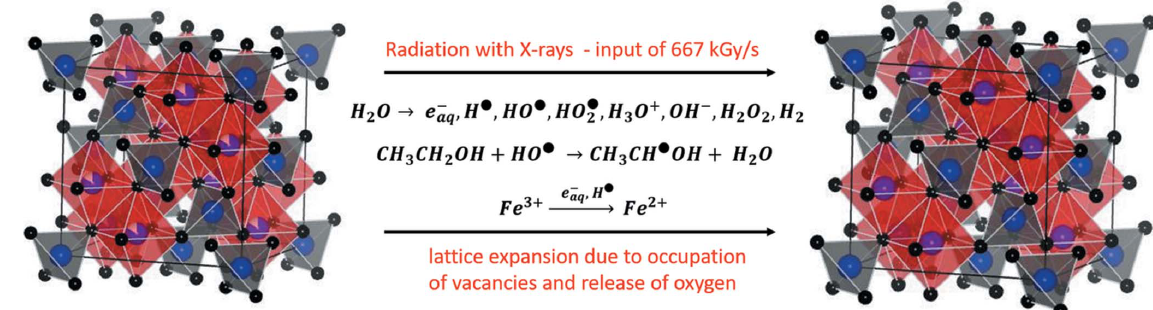
Figure 2 Change of the crystalline structure of the IONPs dispersed in an EtOH–H 2 O mixture with low EtOH concentration upon irradiation with highly brilliant X-rays. Illustrations of the Fd (cid:2) 33 m unit cells have been made using VESTA (Momma & Izumi, 2011). Black balls represent oxygen atoms, blue balls represent iron atoms, vacancies are illustrated by partial filling and the red and grey polyhedra illustrate [FeO 6 ] octahedral and [FeO 4 ] tetrahedral units, respectively. IONPs before radiation with the X-ray beam are non-stochiometric, but mostly containing Fe 3+ (see Section S3 of the supporting information), crystallized in inverse spinel structure (here described with Fd (cid:2) 33 m unit cell for simplicity), therefore possessing vacancies on the octahedral sites (left side). Induced by the irradiation with X-rays, both oxidative and reducing radicals are created by radiolysis of water. Due to the presence of EtOH, the oxidative radical OH (cid:6) is scavenged, a reducing atmosphere is created and Fe 3+ is reduced to Fe 2+ , which fills the vacancies and leads to expansion of the crystal lattice due to its bigger ionic radius (unit cell on the right